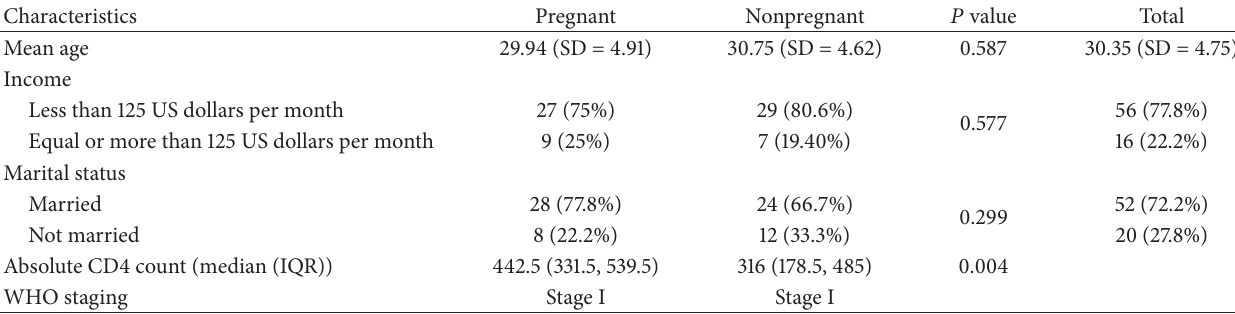
Table 1: Social-economic and demographic characteristics of the study groups.